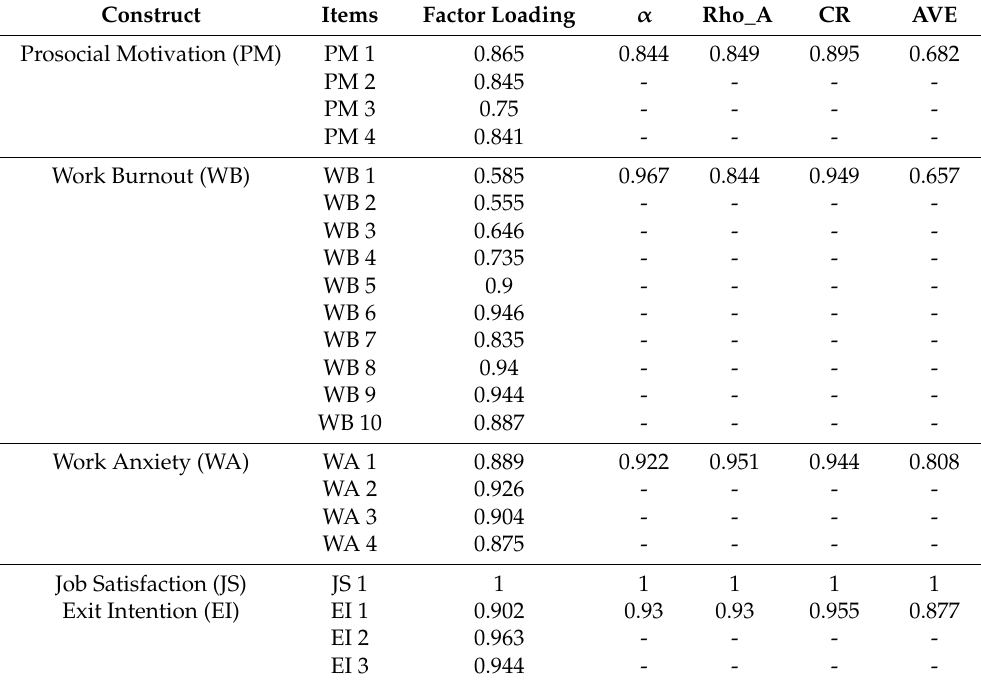
Table 2. Reliability and AVE of the outer